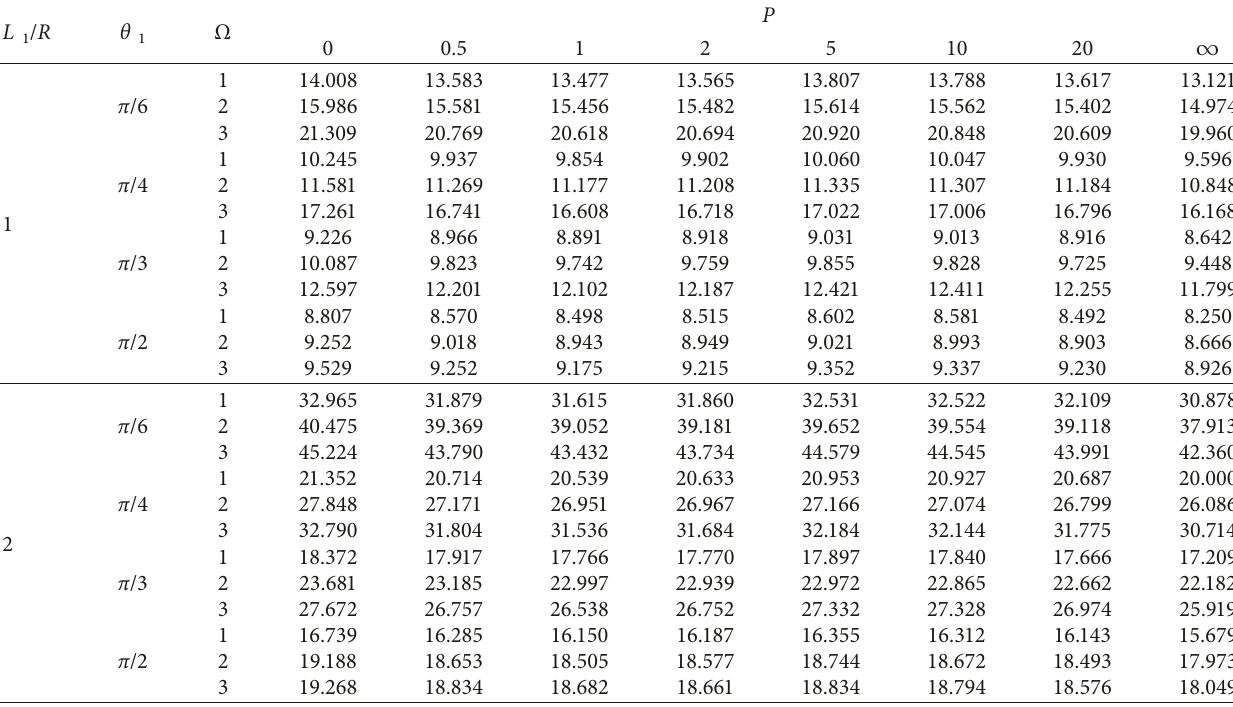
Table 6: Frequency parameters for FGM � 1/ b � 0) open conical shell with one axial bulkhead and CCCC boundary condition according I ( a